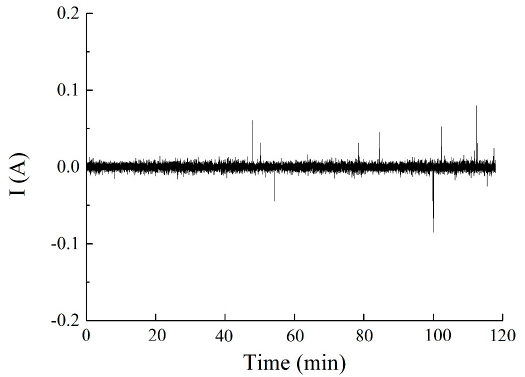
Figure 8. The leakage current of ice-covered insulator during the icing process (800 μ S/cm).